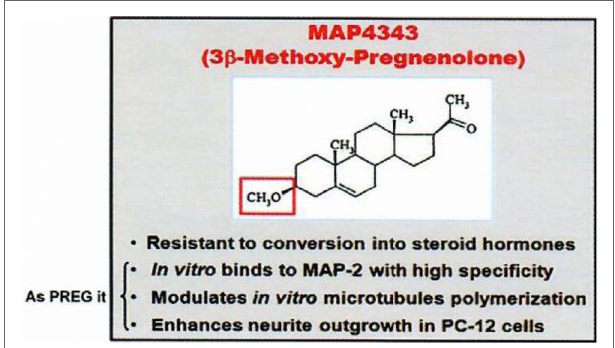
FIGURE 2 | MAP4343, a pregnenolone derivative. Data from Baulieu (8).